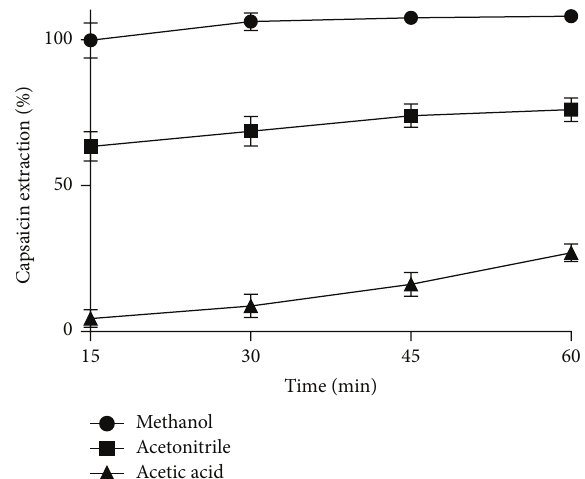
Figure 7: The effect of different solvents and extraction time on capsaicin